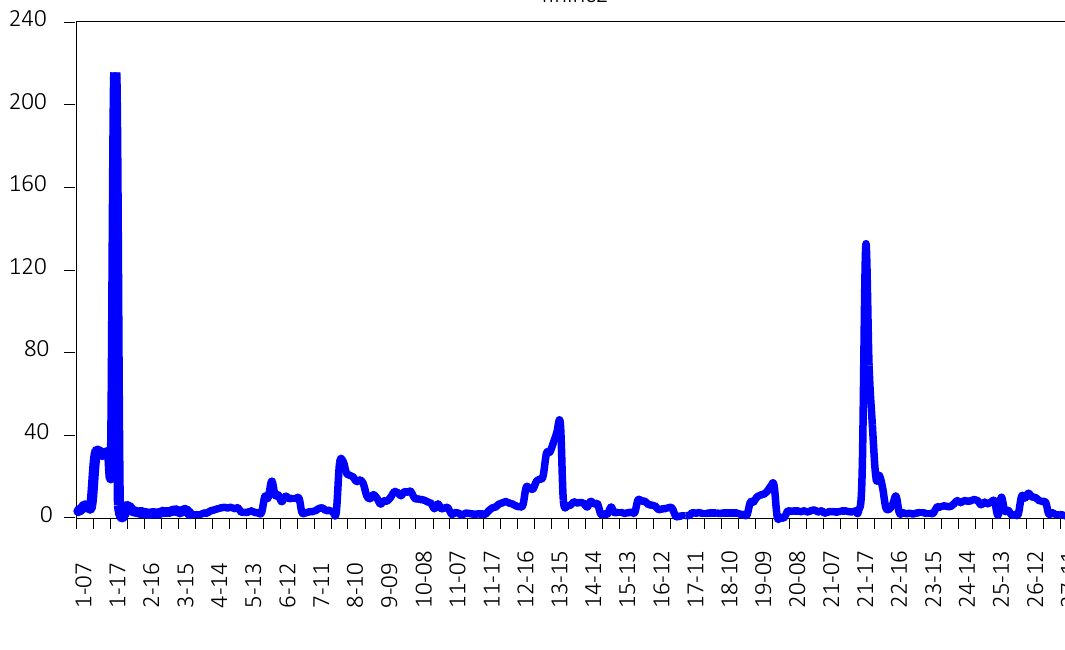
Figure 2. Line graph showing movements of financial inclusion by quality